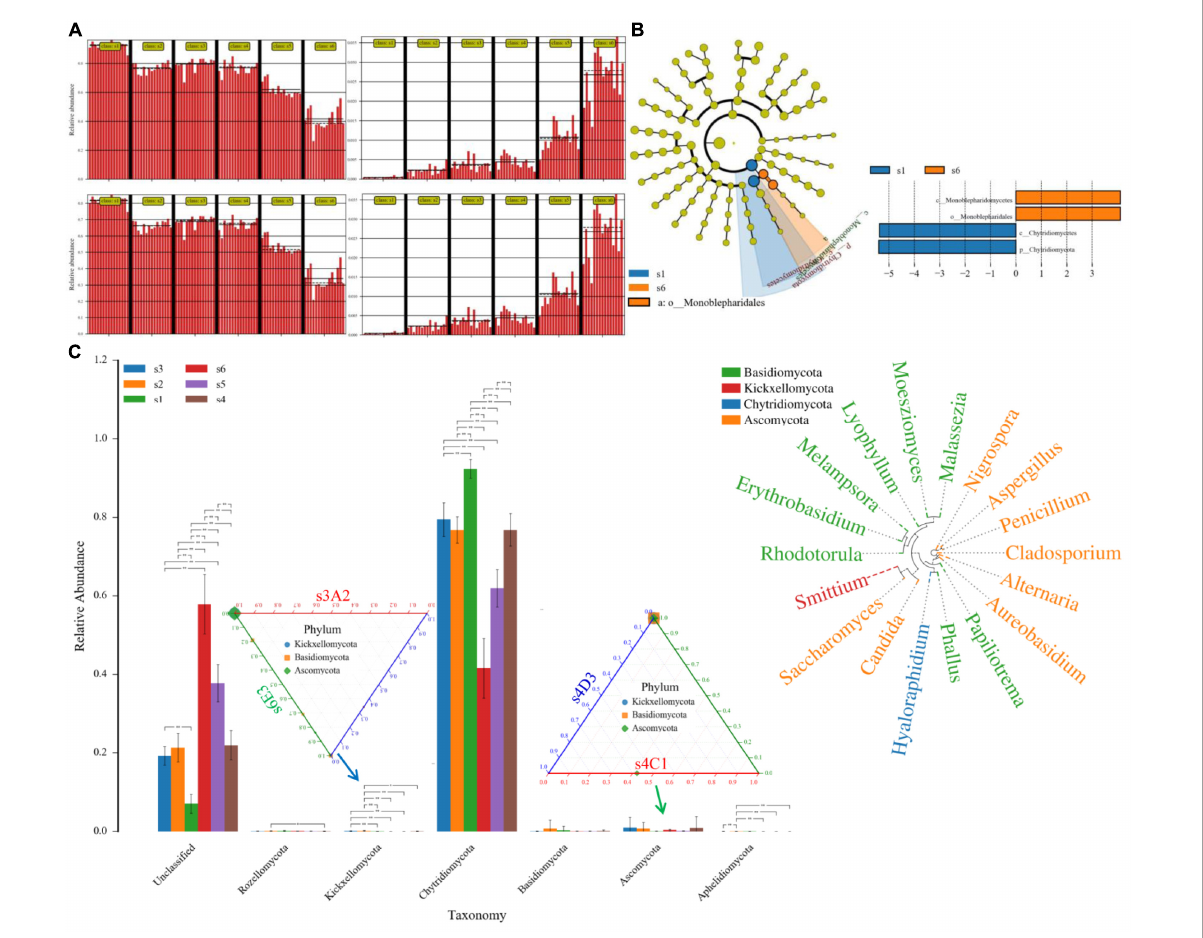
FIGURE4 Fungal species-abundance clustering image at different category levels. (A) , the significant difference of sample via heatmapby binary_jaccard_dm. method; (B) , biomarkers via the lefse and cladogram method; (C) , group ANOVA result in the phylum level, the relative abundance among the comparisons of s4C1 vs. s4D3, s3A2 vs. s6E3, while the relative abundance of the genus has also been revealed. Ascomycota ( Nigrospora, Aspergillus, Cladosporium, Alternaria, Candida ), Basidiomycota ( Malassezia, Lyophyllum, Phallus ), and Kickxellomycota ( Smittium ) increased. The relationship between the selected taxonomy group (abundant species, genera, classes, orders, or families) was calculated using SPSS 25.0